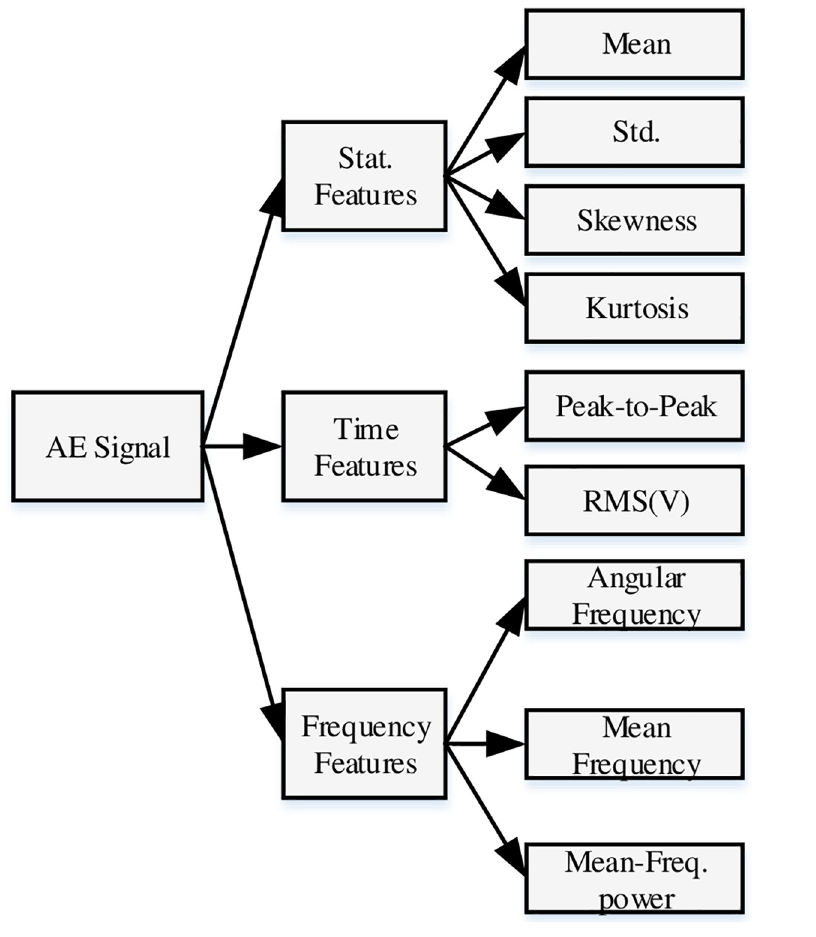
Fig 6. Different types of AE